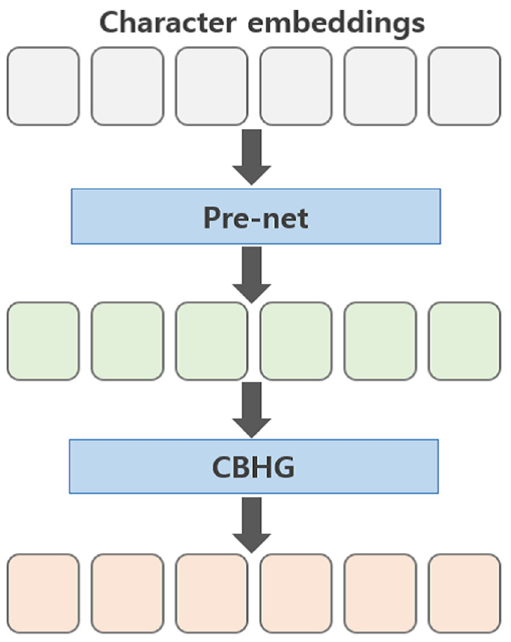
Figure 4. The architecture of Tacotron encoder [16].